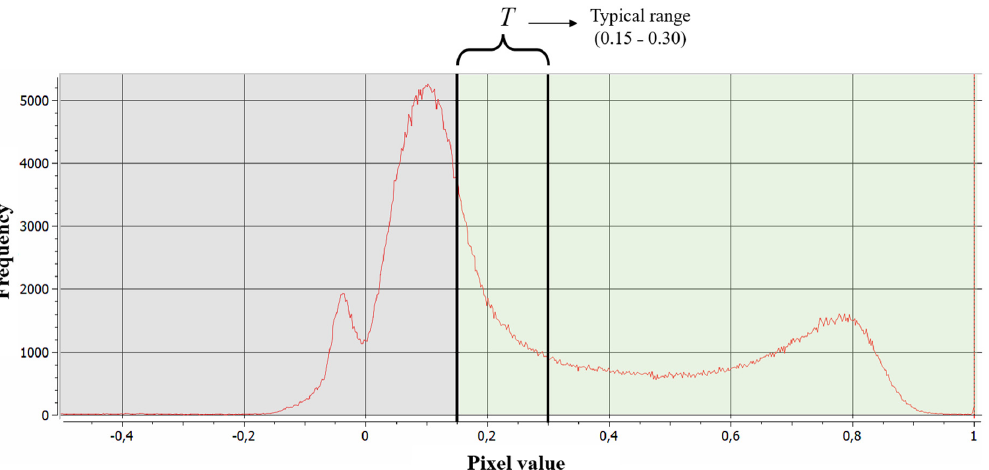
Figure 8. Orthomosaic histogram of the Normalised Differention Vegetation Index (NDVI) of a vineyard showing the soil thresholding method, the red line represents the frequency curve of pixel values.